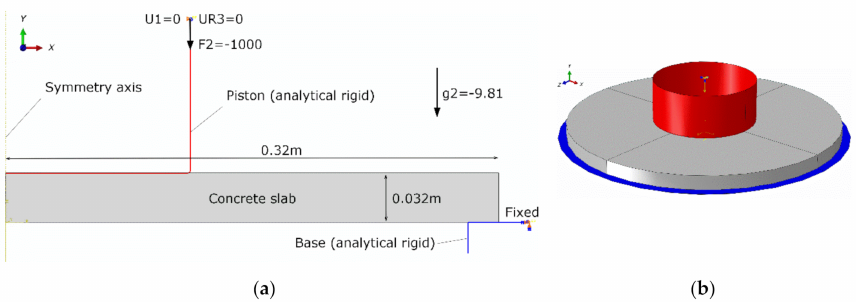
Figure 10. Geometry and boundary conditions (SI units) of the finite element model: ( a ) axisymmetric model, ( b ) 3D model view.